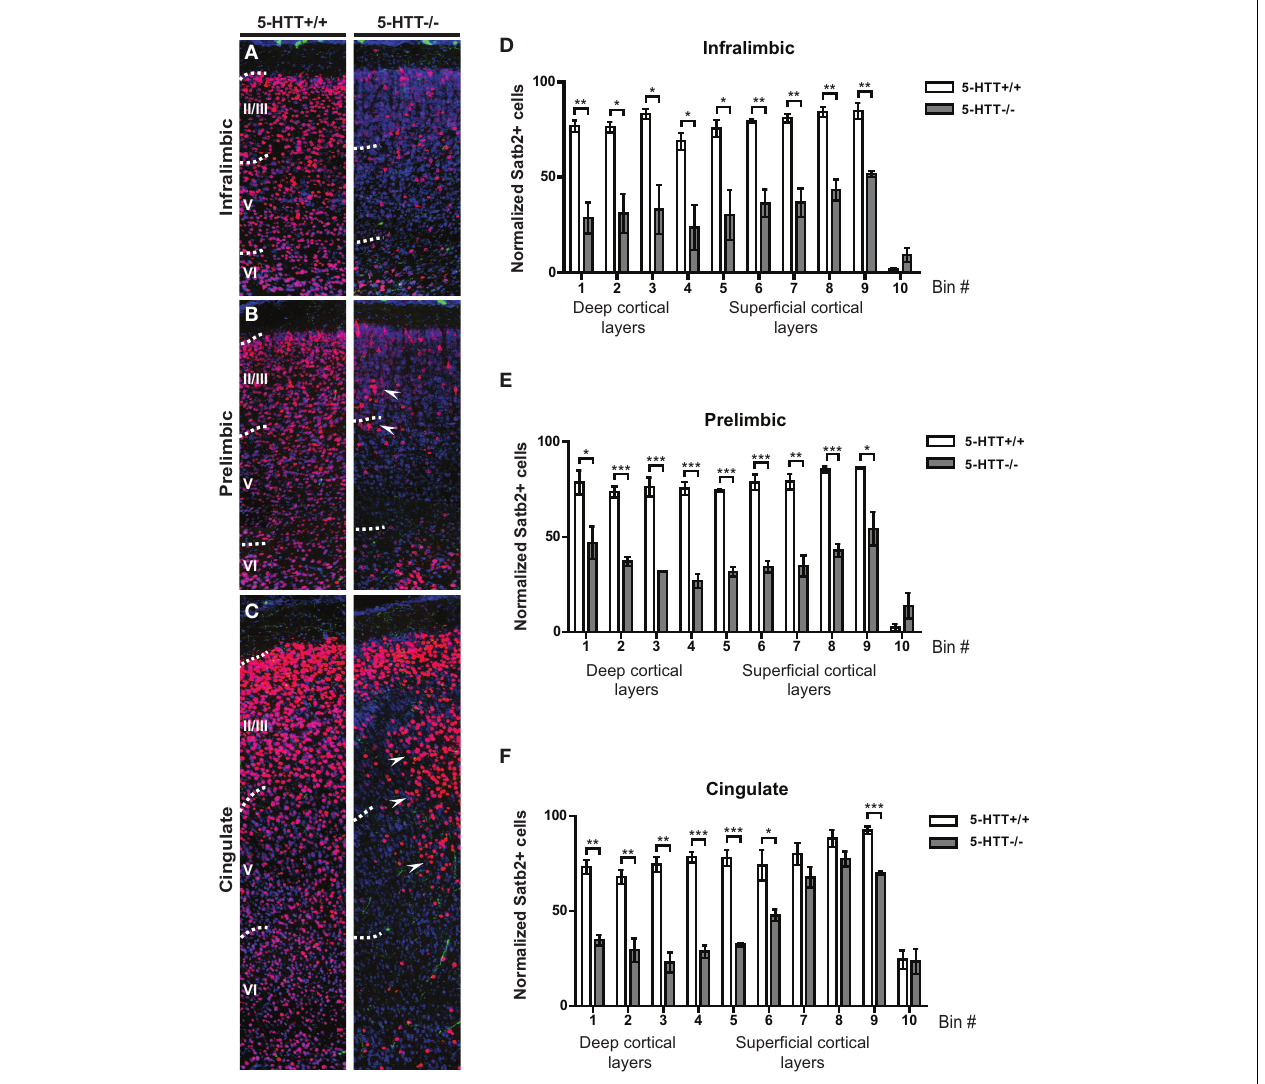
FIGURE 6 | Projection neuron identity is altered in absence of the 5-HTT during development. (A) Coronal sections immunostained for 5-HT (green), Satb2 (red) and counterstained with fluorescent Nissl (blue) of 5-HTT + / + and 5-HTT − / − IL showing the position of callosal projection neurons (presumptive layer II-V). (B) Coronal sections of the PL as in (A) . (C) Coronal sections of the Cg as in (A) . Arrowheads indicate clusters of misplaced neurons. (D) Quantification of the number of Satb2-positive cells in 10 bins dividing the IL confirming the qualitative observations as seen in